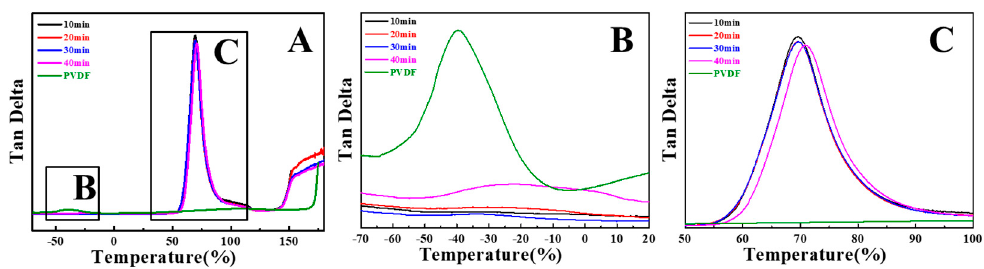
Figure 6. PVDF / PLLA / MG02 blends with various mixing time: complete dynamic mechanical analysis (DMA) curves ( A ), PVDF glass transition temperature region ( B ) and PVDF glass transition temperature region ( C ). Table 2. Comparison table of DMA data and elongation at break.